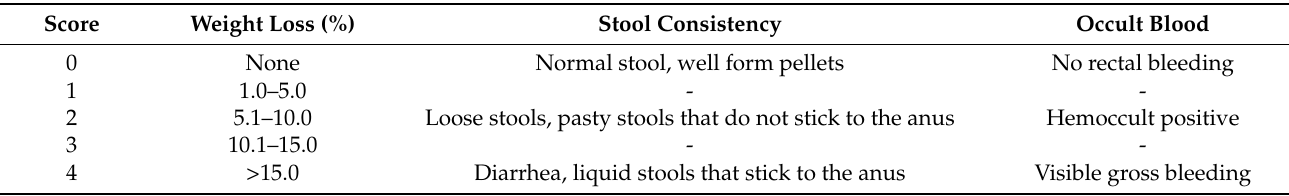
Table 1. Assessment of disease activity index